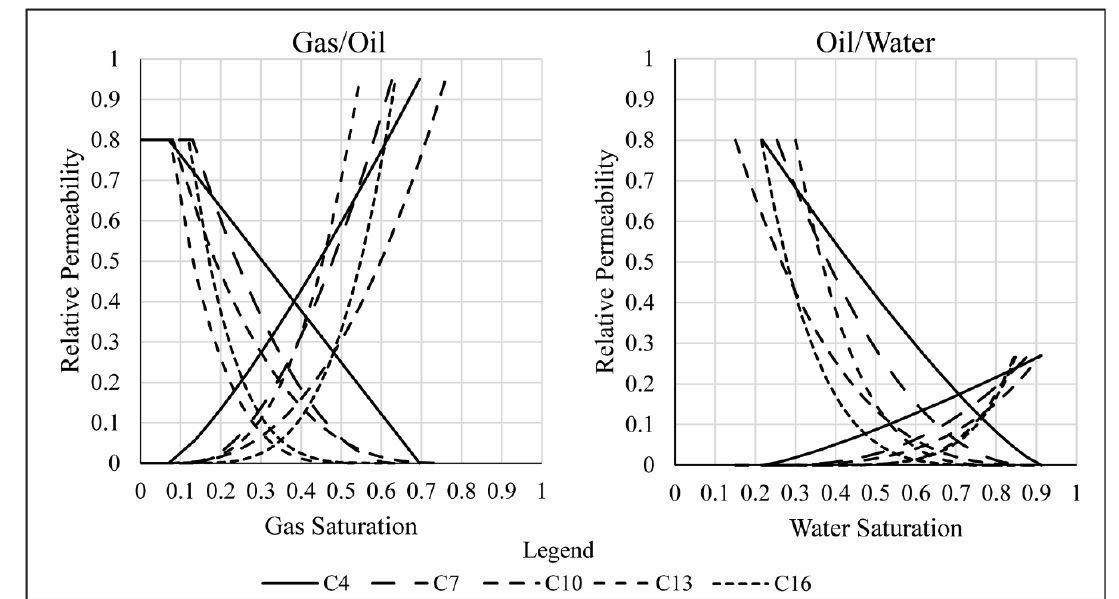
Figure A2. The C4, C7, C10, C13, and C16 relative permeability curves. The saturation endpoints and curvature are varied and the relative permeability endpoints are fixed.